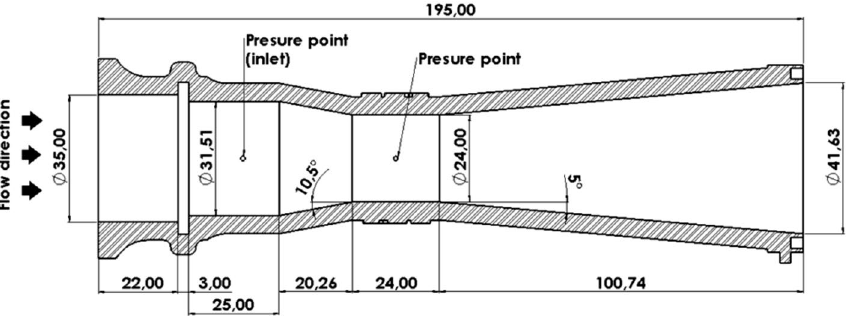
Figure 2. Diagram of the Venturi tube used to measure the inlet flow rate (lengths in mm). Created with Openscad 2021.01, openscad.org.